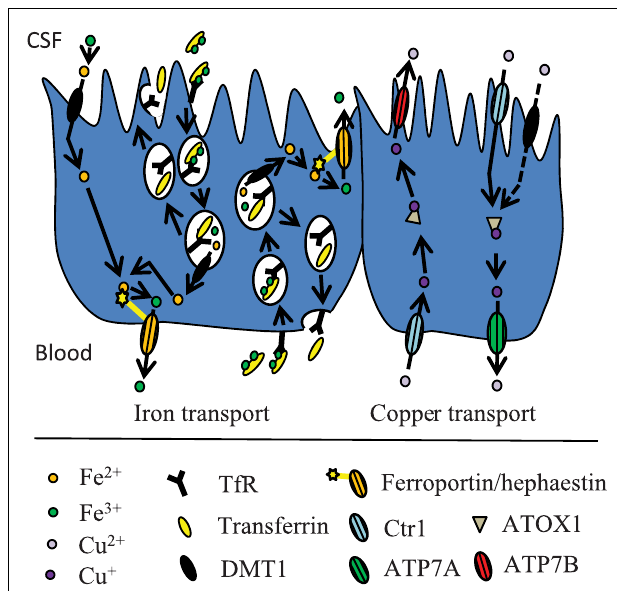
FIGURE 3 | Proposed model for iron and copper transport across the BCB. The mechanisms are described in the text.